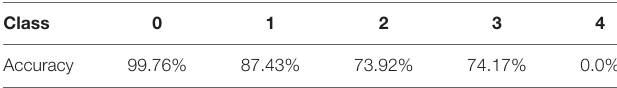
TABLE 9 | Accuracy per class of the most suitable model in this study